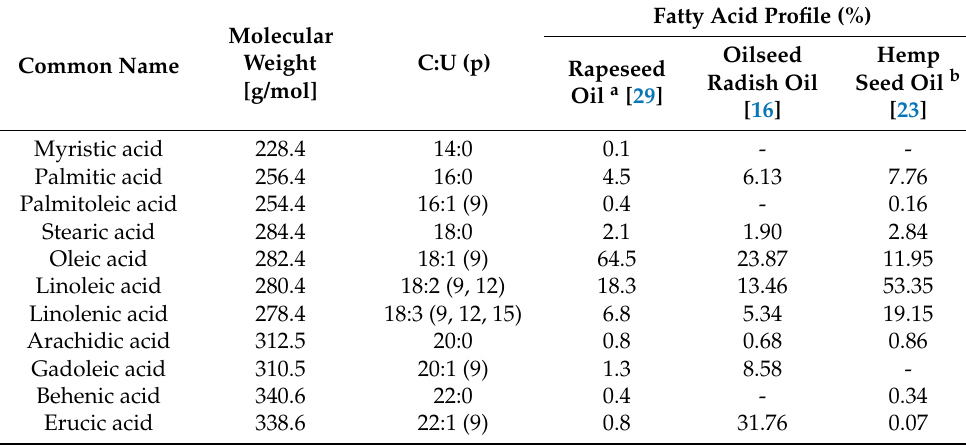
Table 1. Fatty acid content of the oils based on the literature references.